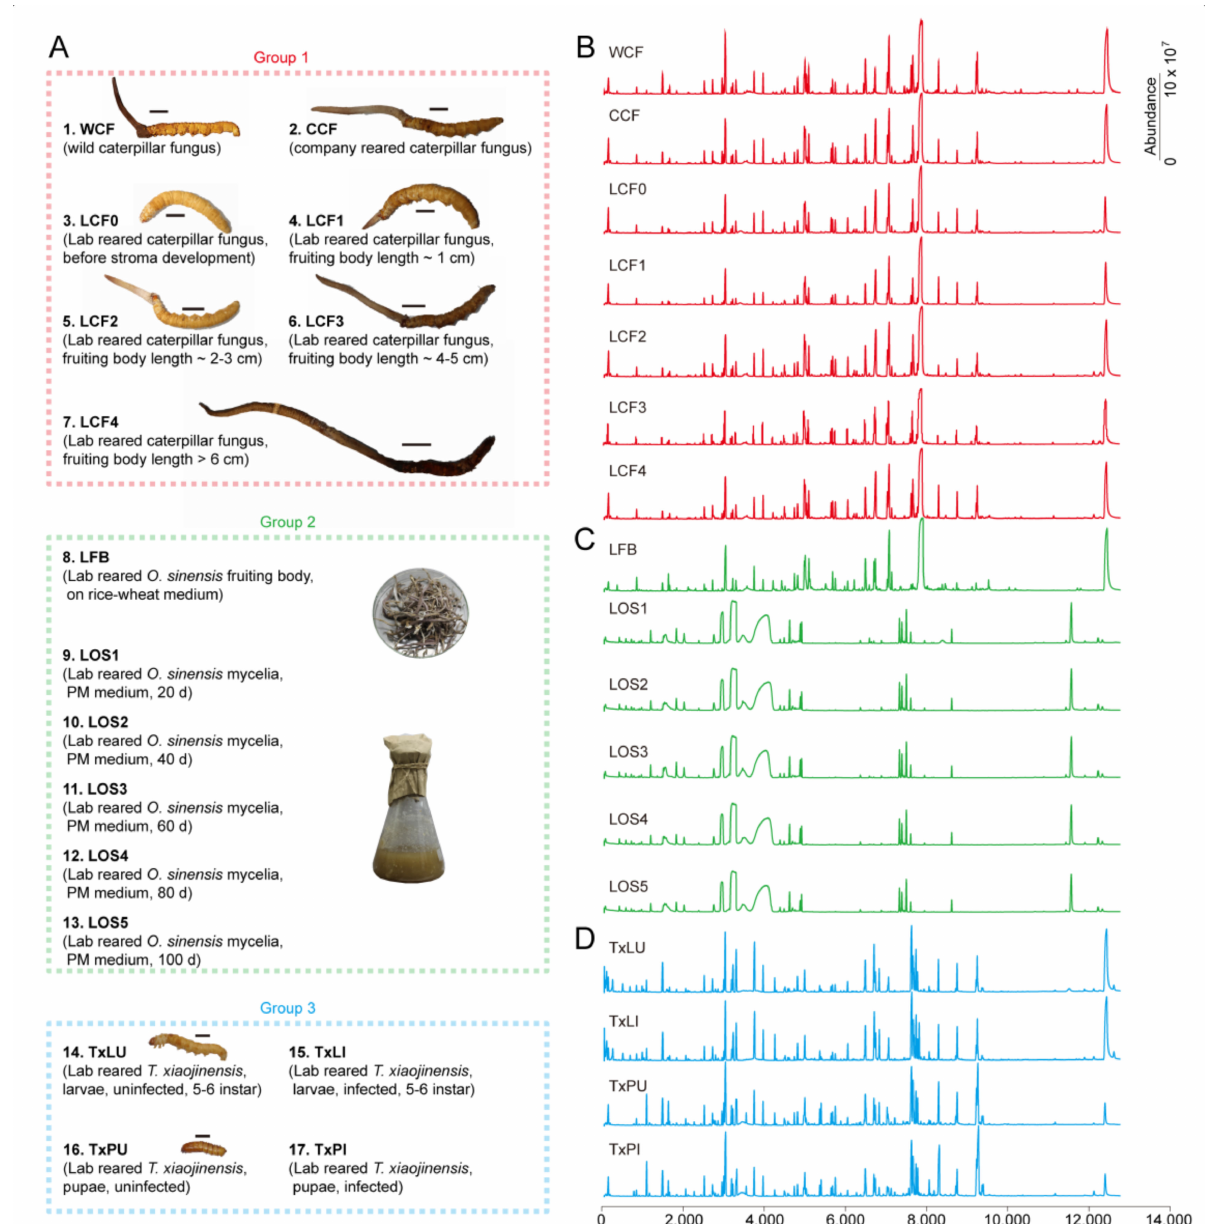
Figure 1. Group setups and example traces of treatments. ( A ) Definition of groups. Group 1 included wild and reared cordyceps. Group 2 included reared fruiting body and mycelia of O. sinensis . Group 3 included T. xiaojinensis insect host. Detailed descriptions and identifiers for the treatments were provided in Table S1. Each treatment contained n = 50 samples and 3 replicates. ( B ) Traces show treatments of caterpillar fungus (WCF, CCF, LCF0, LCF1, LCF2, LCF3 and LCF4). ( C ) Traces show treatments of reared O. sinensis alone (LFB, LOS1, LOS2, LOS3, LOS4 and LOS5). ( D ) Traces show treatments of host insects T. xiaojinensisi alone (TxLU, TxLI, TxPU and